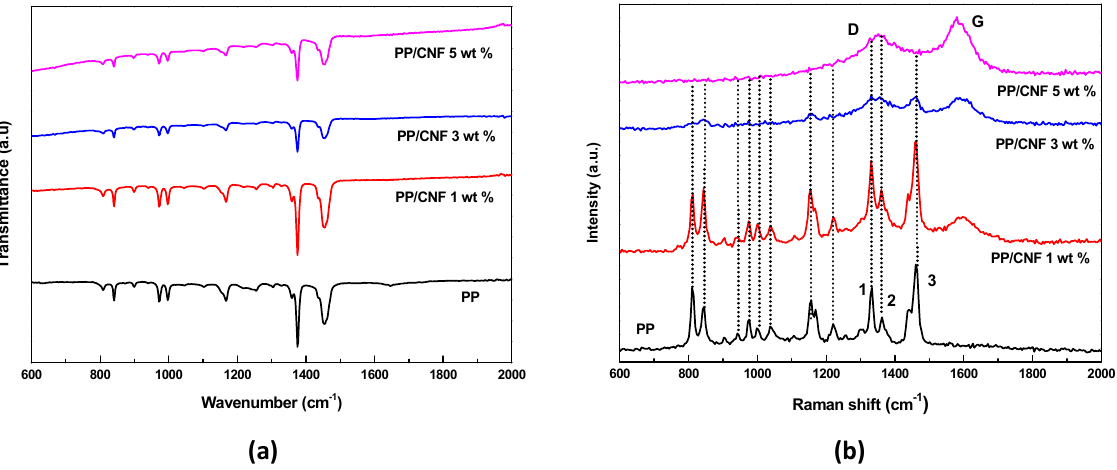
Figure 2. Structural analysis of PP and PP/CNF composites. FTIR ( a ) and Raman spectra ( b ) of PP and PP/CNF composites (the short dot line is to guide the eyes).